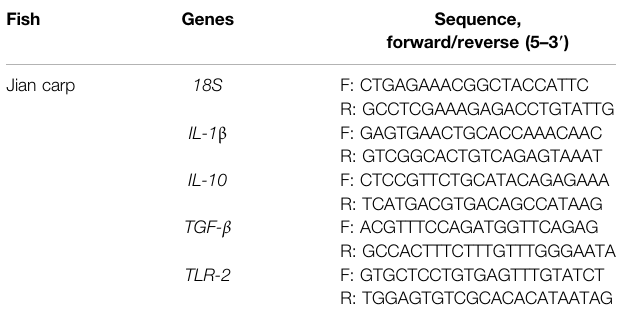
TABLE 1 | List of gene primers used for qPCR.